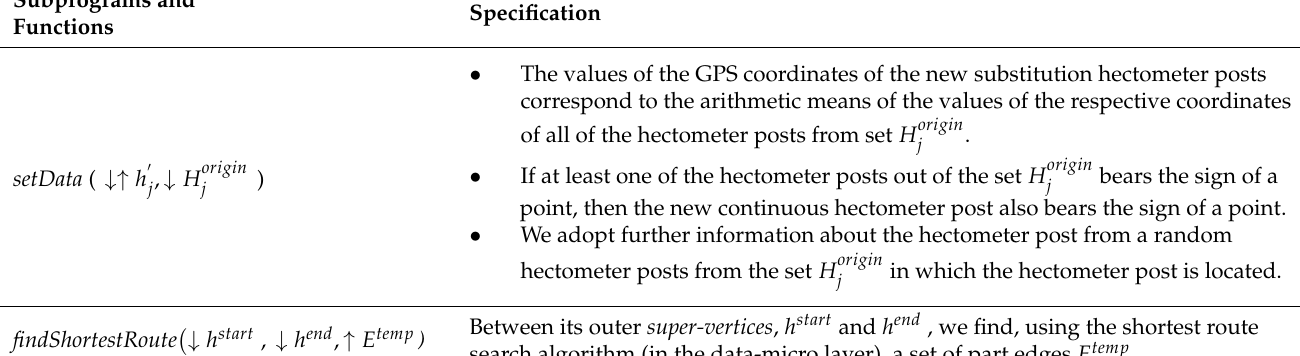
Table 2. Functions.